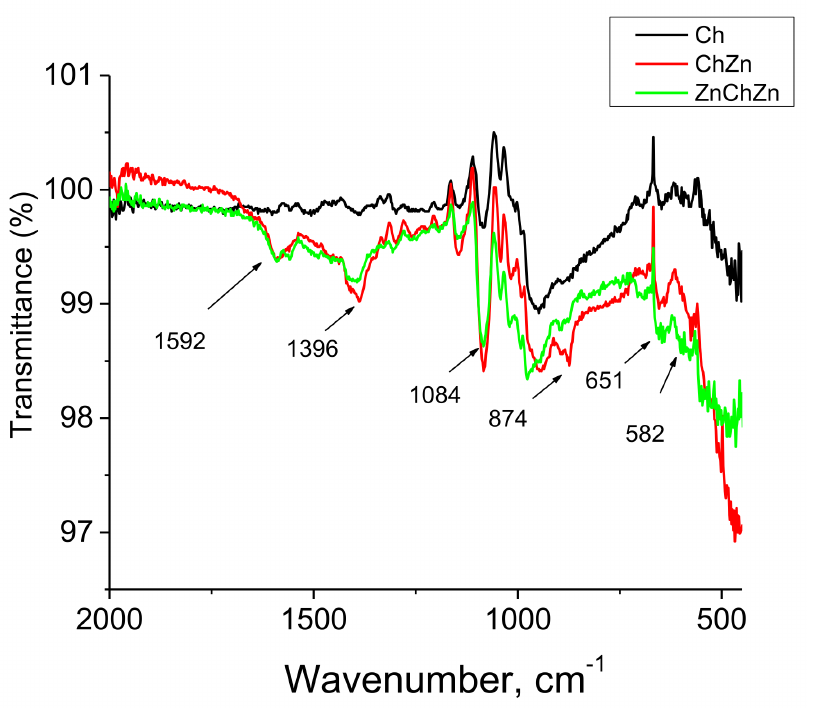
Figure 5. FTIR spectra of the composite materials Ch, ChZn, and ZnChZn as a result of substracting a spectrum of pristine cotton